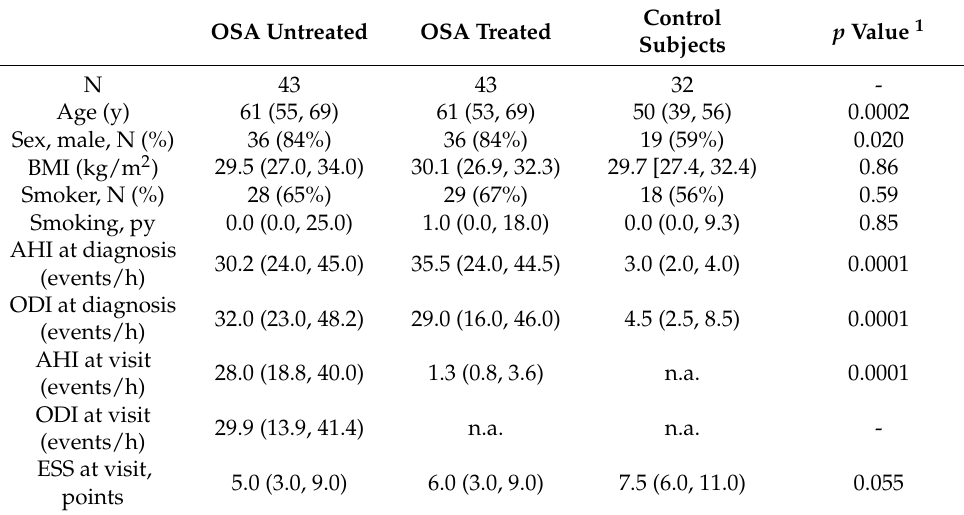
Figure 1. Study profile. In-laboratory sleep reports: polysomnography or respiratory polygraphy. 160 and continuous positive airway pressure (CPAP) therapy. Table 1. Baseline characteristics.